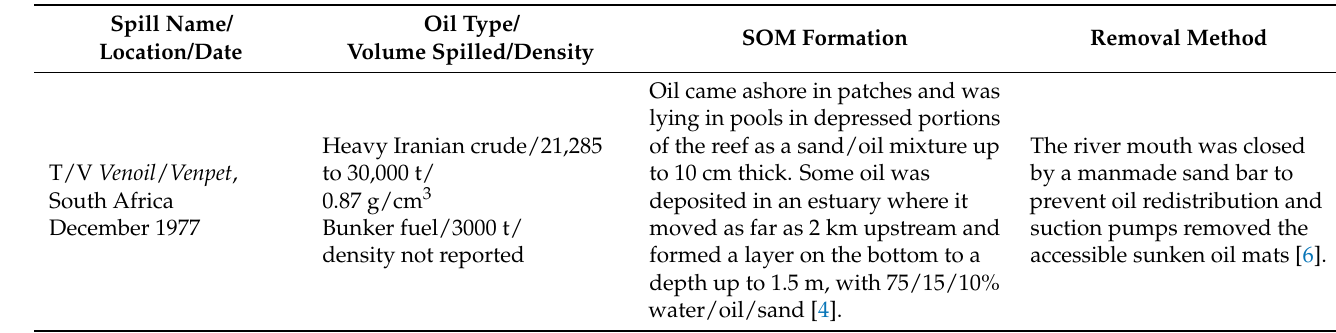
Table 1. Case histories of spills where sunken oil mats were documented, in chronologic order. Volumes are reported in metric tonnes (t). Density is reported as grams per cubic centimeter (g/cm 3